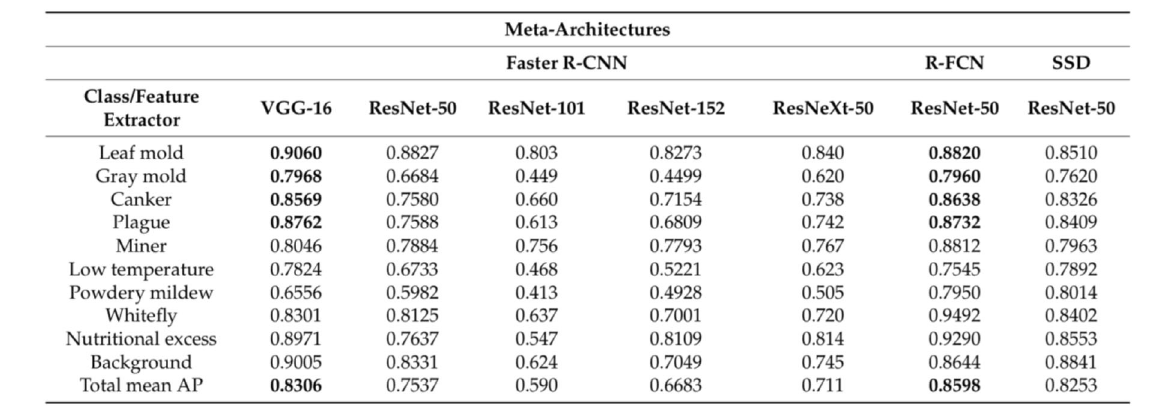
Table 2 Comparison of our proposed method with other